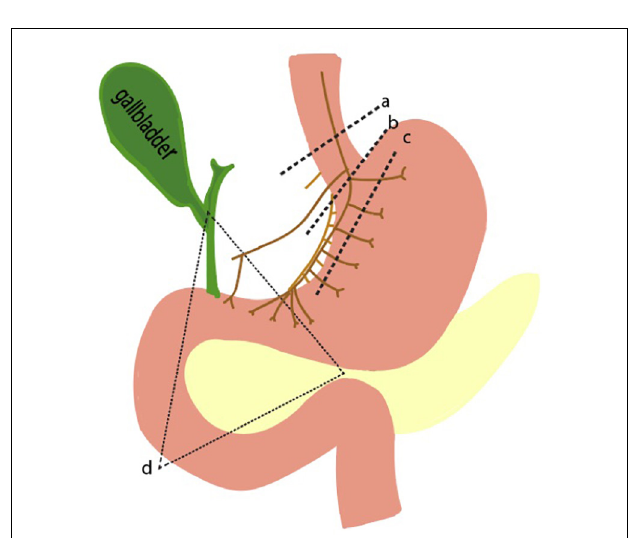
FIGURE 5 | Pathophysiologic basis of gastric acid hypersecretion. Illustrated are selected examples of changes to physiological acid secretion. Lines a,b,c represent surgical transection lines for truncal, selective, and highly selective vagotomies. This reduces cholinergic input for acid secretion. Triangle d is the anatomical region where a gastrinoma is most likely to exist. A gastrinoma provides constitutively high levels of gastrin, leading to overactive parietal cells, and hyperplastic changes in